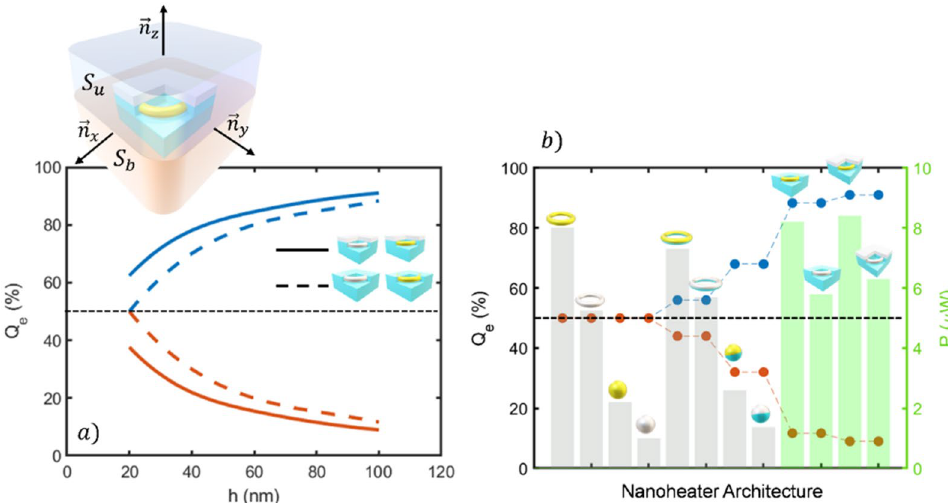
Figure 6. ( a ) Comparative of the relative conductive heat power ( Q e ) flowing through the upper half-space (in blue) and lower half-space (in orange) as a function of the insulator thickness h for gold and platinum heating units and both, binary (dashed line) and ternary nanojet (solid line) designs. Inset: Scheme of the conductive thermal power calculation method applied to the nanojets where S u y S b are the upper and bottom half-spaces respectively. n x , n y and n z are the vectors of the canonical basis. ( b ) Comparative of the maximum relative conductive power for all the considered structures: single-material/hybrid nanoheaters in grey and J-Nanojet designs in